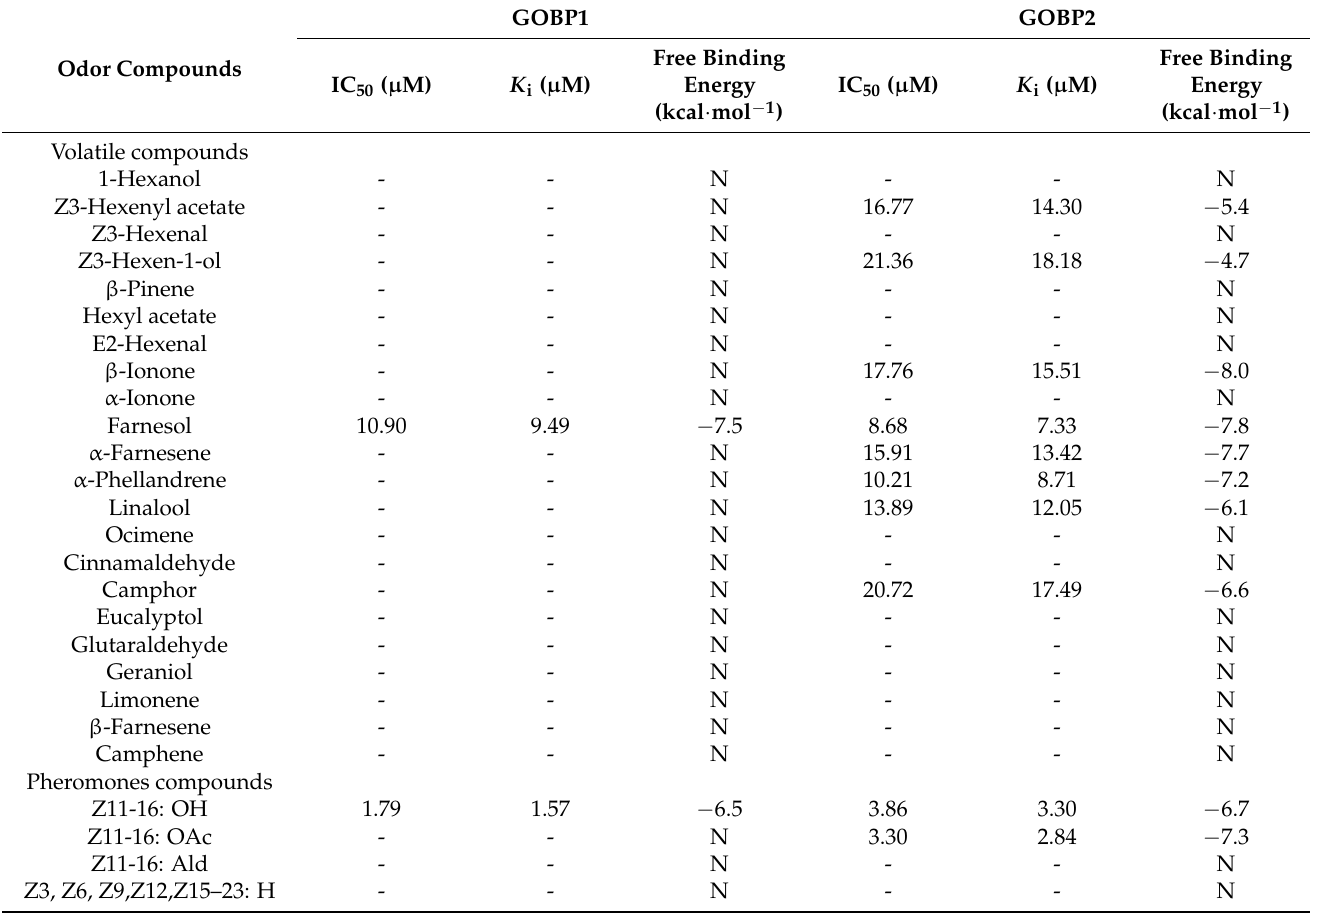
Table 1. Binding data of different ligands to OachGOBPs by binding assay and molecular